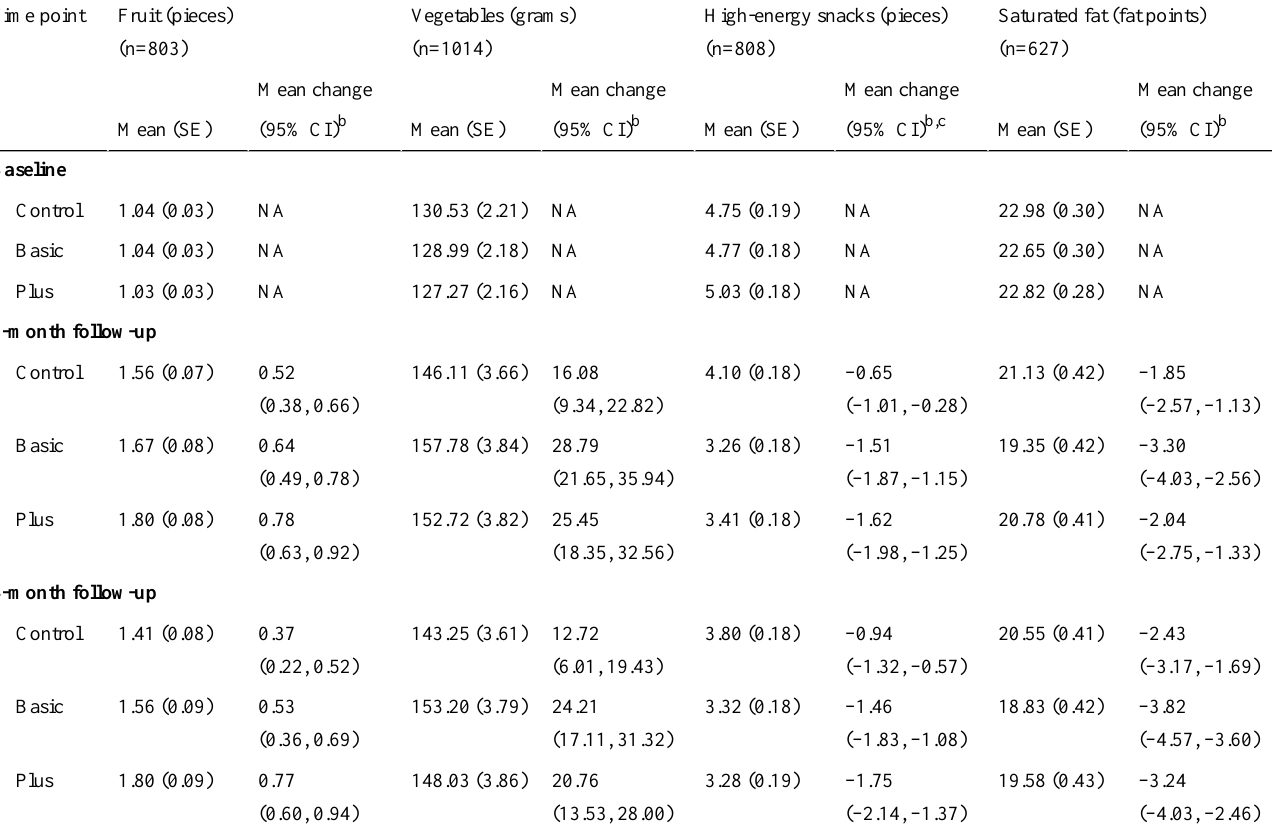
Table 4. Estimated marginal means at baseline and at 1- and 4-month follow-ups and changes over time for the risk groups.